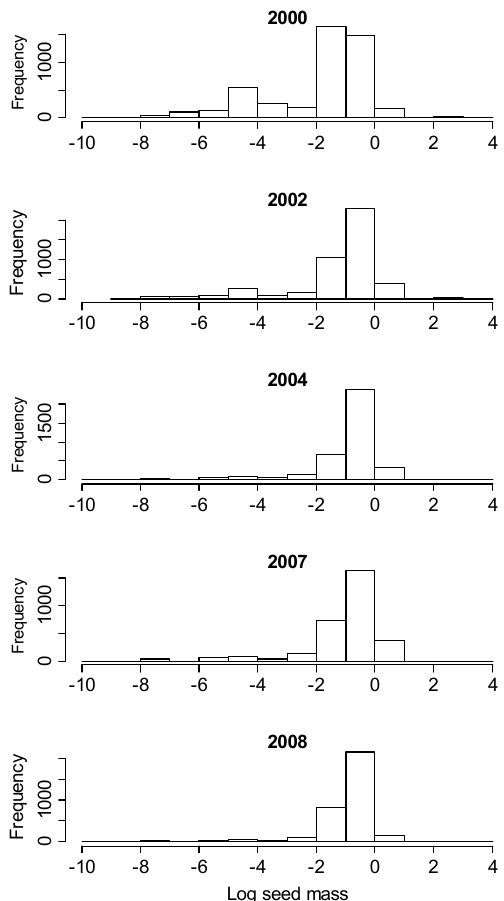
Figure 4. Histograms showing the frequency of log-transformed seed mass values of seedlings in the 150 2 × 1 m seedling plots in the Luquillo Forest Dynamics Plot, Puerto Rico. Each seedling was assigned the mean seed mass value for its species.